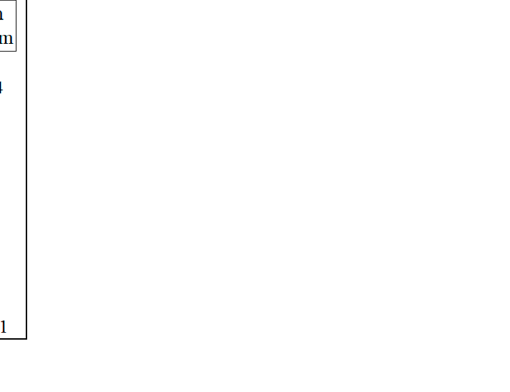
Figure 7. Surface roughness (Rq)/nm of HfO 2 coatings prepared at different deposition tempera- tures.